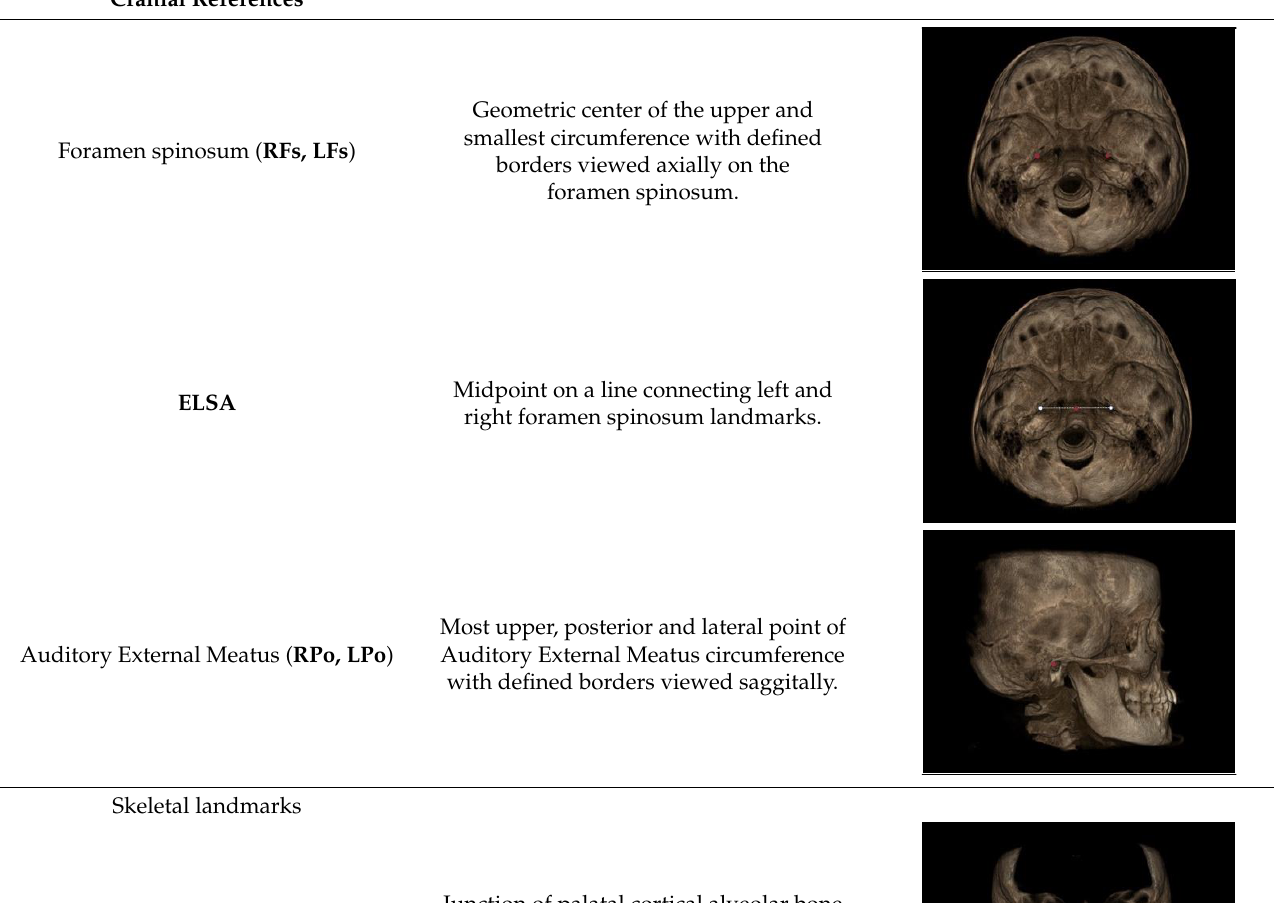
Table 1. Landmark definition, description, and positioning on 3D rendering.